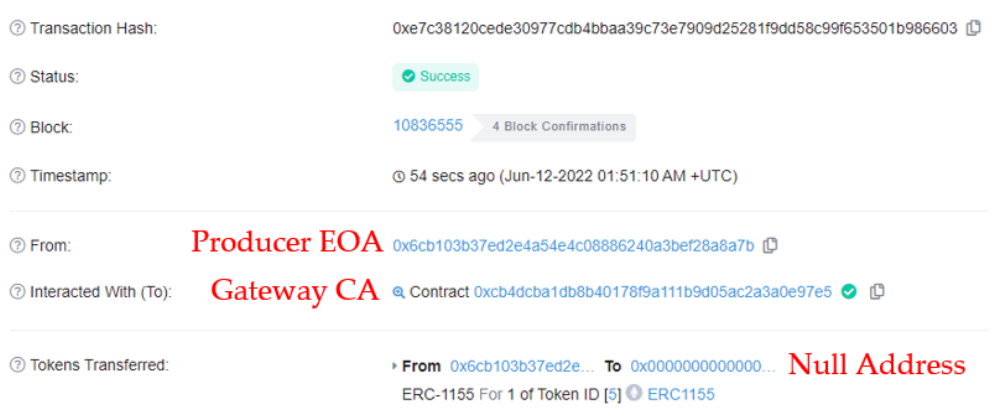
Figure 16. Transaction results when sending expired tokens.